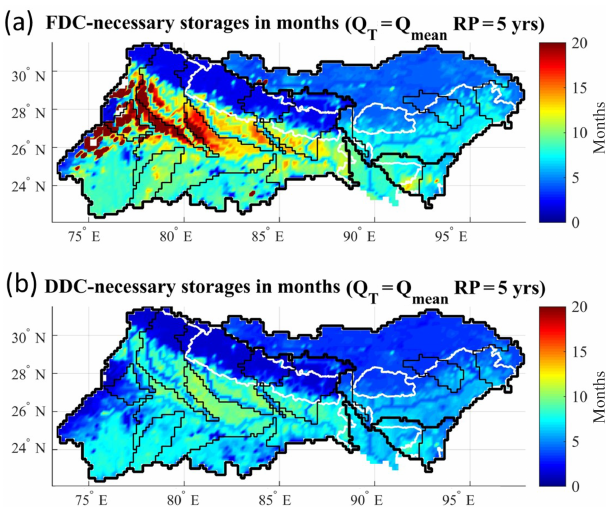
Figure 10. Necessary storage in months for (a) flood and (b) drought management with maintaining discharge Q T = Q mean of return period 5 years. The simulated discharge was for 1980–